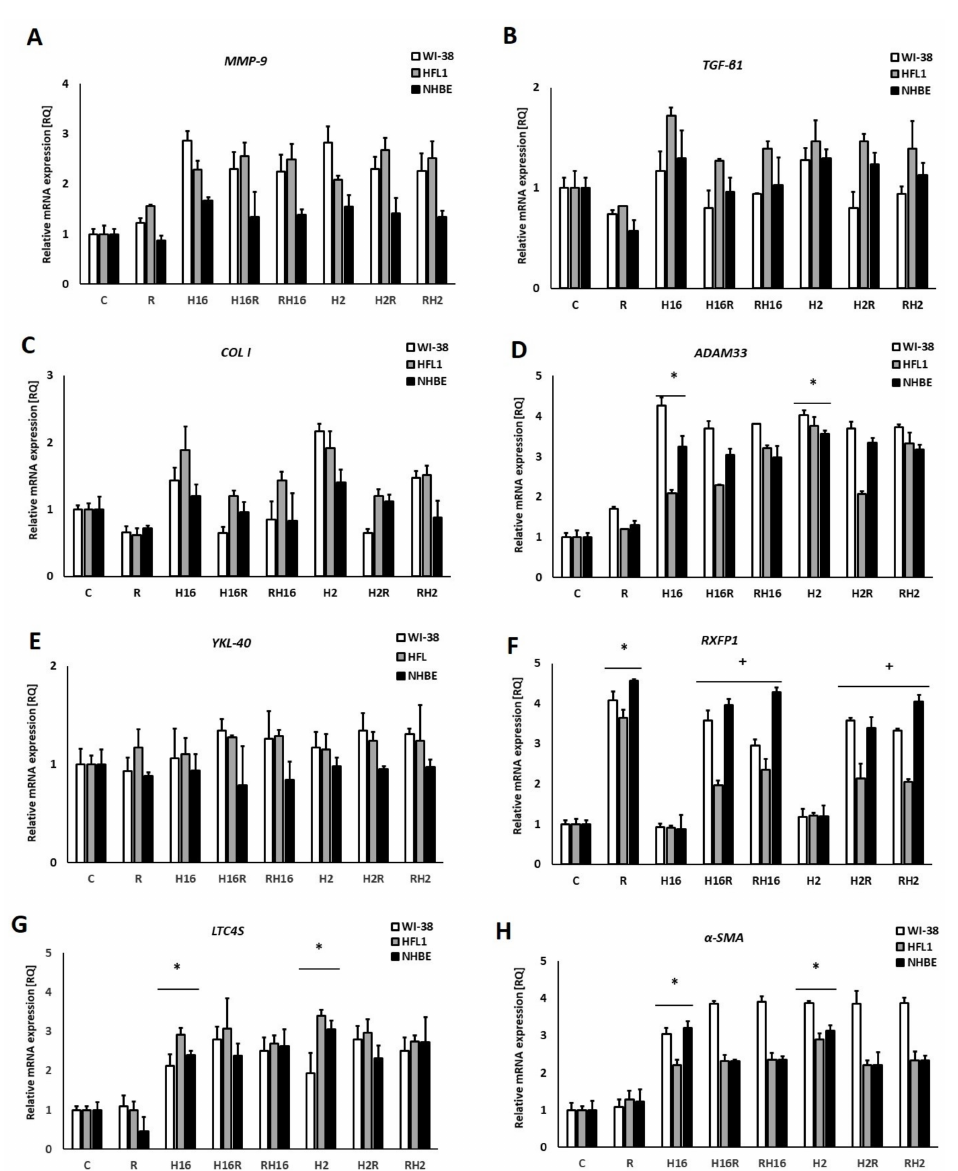
Figure 5. Real-time PCR results presenting the effect of relaxin on the genes contributing airway remodeling after STAT3 siRNA silencing. The knockdown of STAT3 reversed relaxin’s (R) ability to influence MMP-9 (Matrix metalloproteinase 9, ( A )), TGF- β (Transforming growth factor beta, ( B )), COL I (collagen I, ( C )), and α - SMA ( α -smooth muscle actin, ( H )) mRNA expression. The knockout did not change levels of ADAM33 (ADAM Metallopeptidase Domain 33, ( D )), YKL-40 ( E ) and LTC4S (leukotriene C4 synthase, ( G )) mRNA expression in comparison to cells expressing STAT3 . Relaxin increased mRNA expression of RXFP1 ( F ). Moreover, no difference were observed between the specimens when relaxin was added to cells infected with rhinovirus-16 (H16) and rhinovirus-2 (H2) or prior to the HRV infection. H16R, H2R—rhinovirus 16 and 2 added first, followed by relaxin—after 24 h, as well as RH16, RH2—relaxin added first, followed by rhinovirus 16 and 2—added after 24 h. The data presented are normalized to the samples treated with control siRNA. * p < 0.05 in comparison to the control sample, and + p < 0.05 in comparison to the rhinovirus sample (HRV-2 or HRV-16, respectively); C is the control sample with medium only. N = 6, error